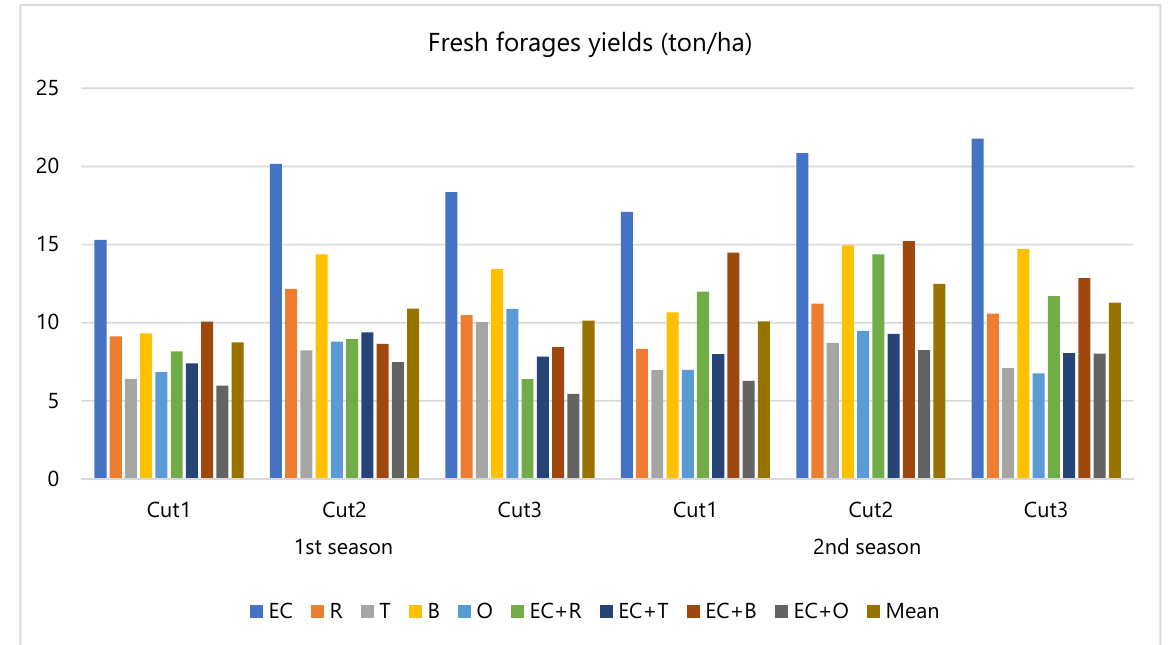
Figure 2. Means of fresh forage yields (ton/ha) obtained at different cuttings of the study. EC = Egyptian clover monoculture, R = ryegrass monoculture, T = triticale monoculture, B = barley monoculture, O = oat monoculture, EC+R = Egyptian clover + ryegrass intercropping, EC+O = Egyptian clover + oat intercropping, EC+B = Egyptian clover + barley intercropping, and EC+T = Egyptian clover + triticale intercropping (L.S.D. forage×cutting ).